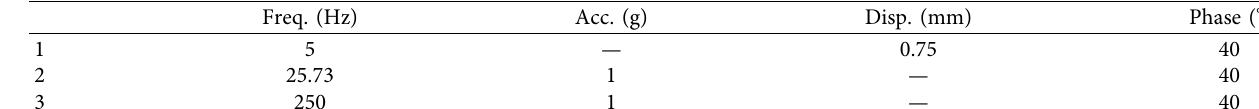
Table 3: Reference spectrum at control point 2.